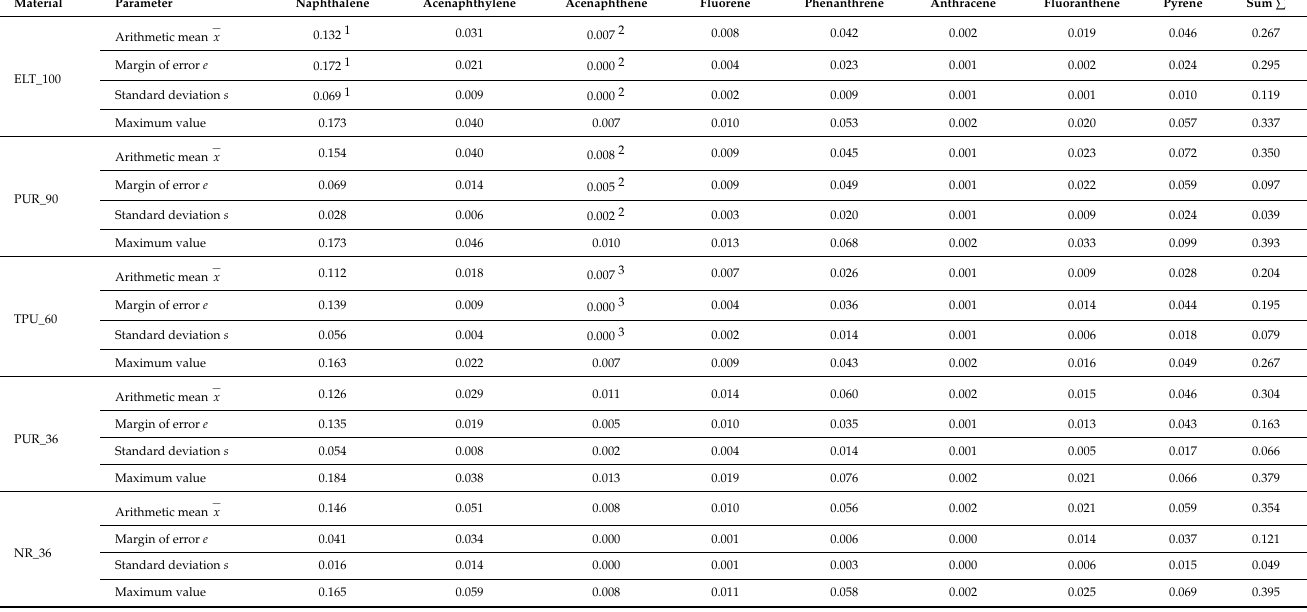
Table 1. Statistical indicators for the specific migration w M of PAH into 20% aqueous ethanol in µ g/dm 2